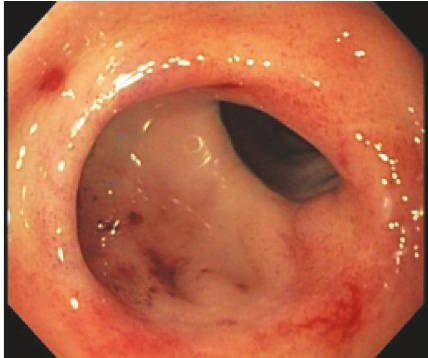
Figure 2: Following intraprocedural ERBE circumferential probe argon plasma coagulation, hemostasis was